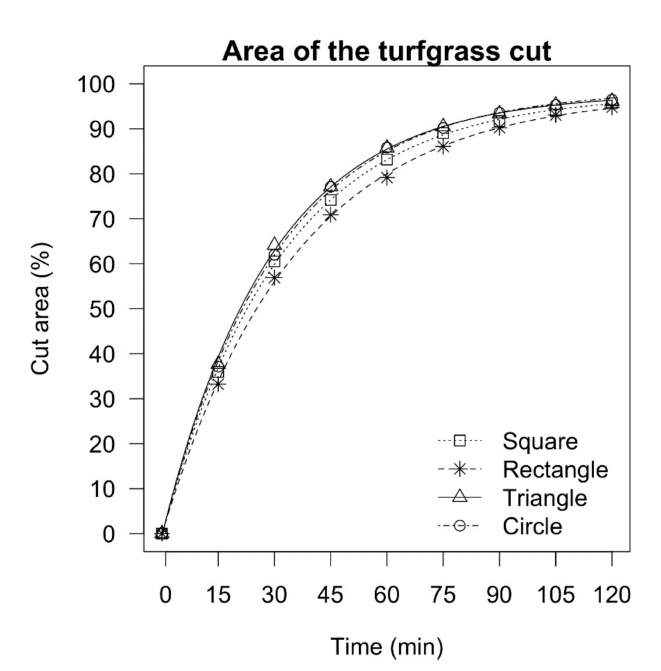
Figure 8. Fitted asymptotic regression curves with averages points of the cut area as a function of the time (min) and the shape of the turfgrass area. This graph is the result of a simplified model (which follows a non-linear two-parameter asymptotic regression but not the two-stage meta-analysis dose-response model), because the package ‘medrc’ of R [41] used for the analysis was not yet programmed to graph